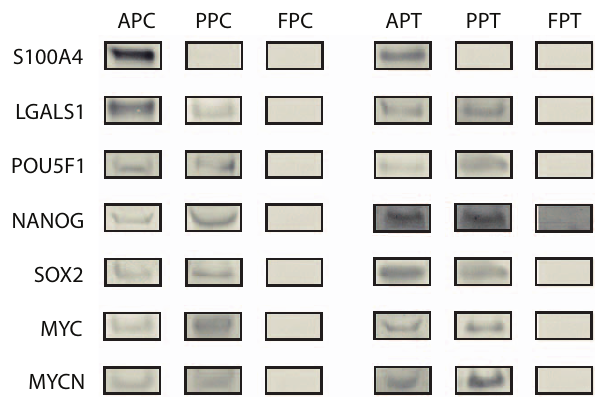
Figure 7. Western blot gels for AP, PP and FP cells and tissues. The gels show the signalling molecules and transcription factors detected in this study. Note that the results from the cultured cells and from the tissues were consistent: S100A4 only expressed in AP; LGALS1, POU5F1, Nanog, SOX2, MYC, and MYCN expressed only in AP and PP, but not in FP. AP, antlerogenic periosteum; PP, pedicle periosteum; and